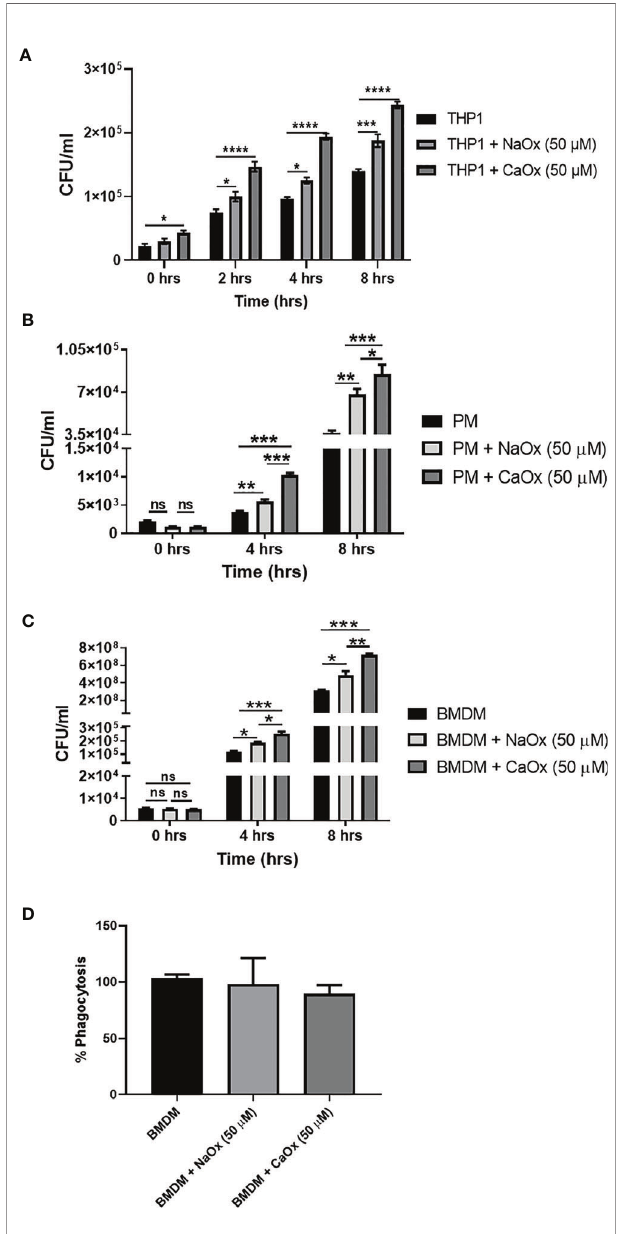
FIGURE 4 | Oxalate increases bacterial burden in macrophages. Macrophages were exposed to sodium oxalate (NaOx; 50 m M) or calcium oxalate crystals (CaOx; 50 m M) for 72 hrs followed by CFT073 infection (MOI 1: 5) for 2, 4, or 8 hrs. Data represent CFU recovery from (A) THP-1 macrophages; (B) Peritoneal macrophages, and (C) BMDMs. (D) Percent phagocytosis of BMDM. All experiments were performed in triplicates. Data are expressed as mean ± SEM. ns, not signi fi cant *p < 0.05, **p < 0.01, ***p < 0.001, ****p < 0.0001 is signi fi cant compared to control